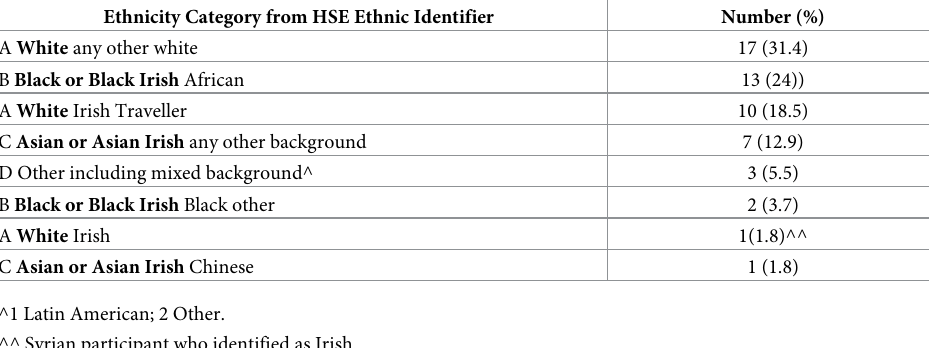
Table 4. GP user participants’ self-identified ethnicity.